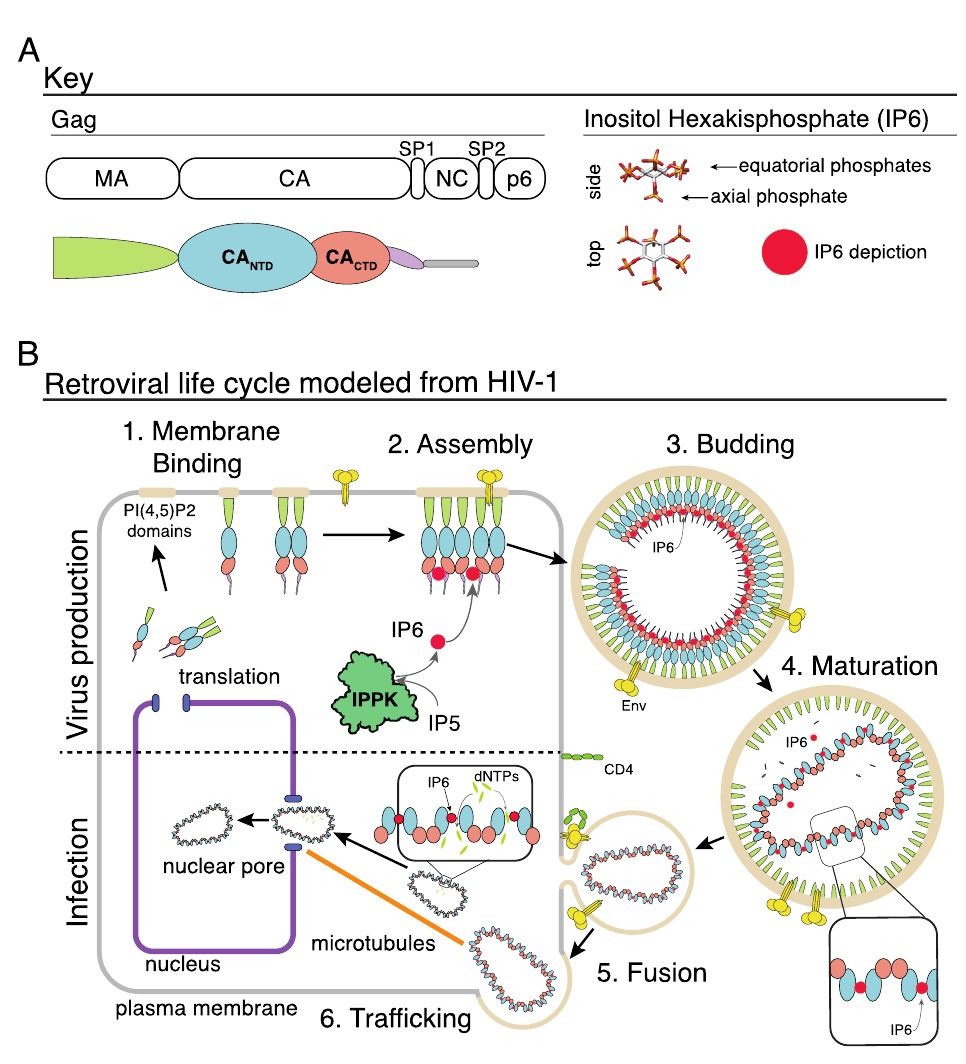
Figure 1. IP6 and the retroviral life cycle. ( A ) Key of the HIV-1 Gag domains on left. Right shows the d-myo-IP6 molecule. ( B ) 1: Gag protein interacts with the inner leaflet of the cellular plasma membrane. 2: Interactions between Gag, the plasma membrane, nucleic acid, and IP6 result in the assembly of the immature Gag lattice. 3: Assembled virion buds from cell with IP6 bound to two rings of six lysine residues at the Gag hexamer interface. 4: Retroviral protease cleaves the Gag protein, resulting in the liberation of the CA domain. CA interacts with IP6 via a ring of six arginine residues in the CA NTD hexamer interface, which leads to the formation of the mature core. 5: Interaction between the viral Env protein and the cell receptor (CD4 in this example) results in fusion, and release of the viral core into the cell cytoplasm. 6: Trafficking of the viral core along microtubules to the nuclear pore. Once in the cytoplasm, dNTPs enter the capsid core where they “feed” reverse transcription of the viral RNA genome into double-stranded DNA. Once at the nuclear pore, or inside the nucleus, the capsid core breaks open, releasing the integration